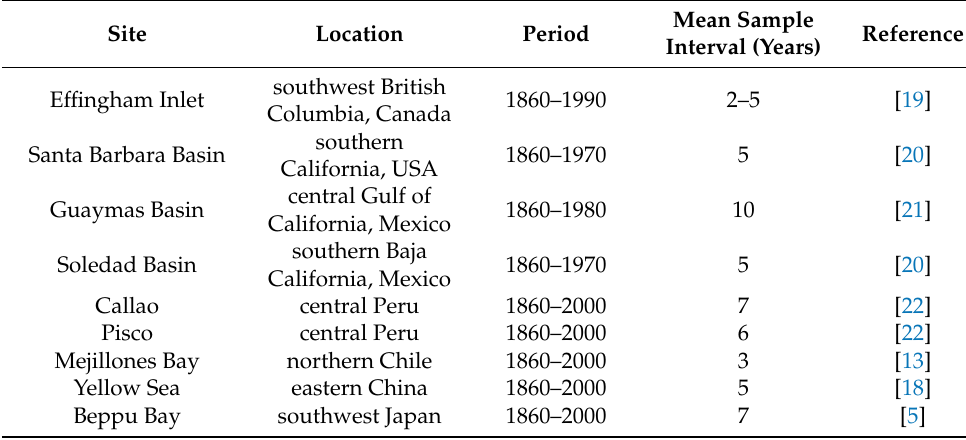
Figure 1. The map of research sites in the Pan-Pacific. Arrows represent the ocean currents. Warm current (red): Kuroshio Current (KC); cold currents (blue): California and Humboldt Currents (CC and HC). Table 1. SDR data sources for the nine sites examined in the Pan-Pacific.